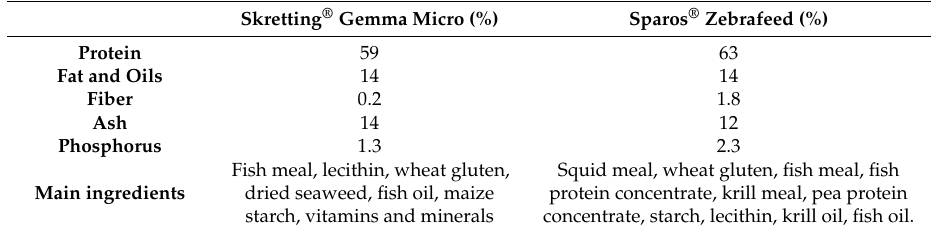
Table 2. Nutritional composition of the processed feeds tested. The nutritional content was the same for all grain sizes. Information was gathered from the products’